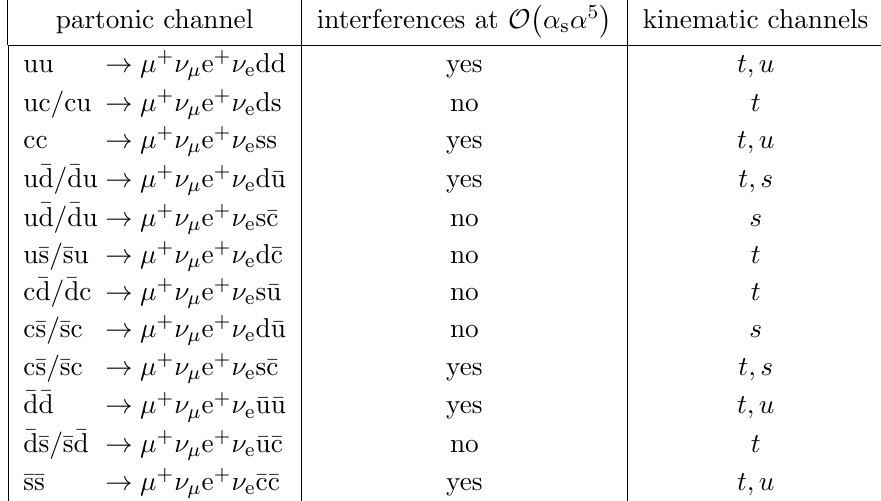
(cid:22) + (cid:23) (cid:22) e + (cid:23) e jj. !